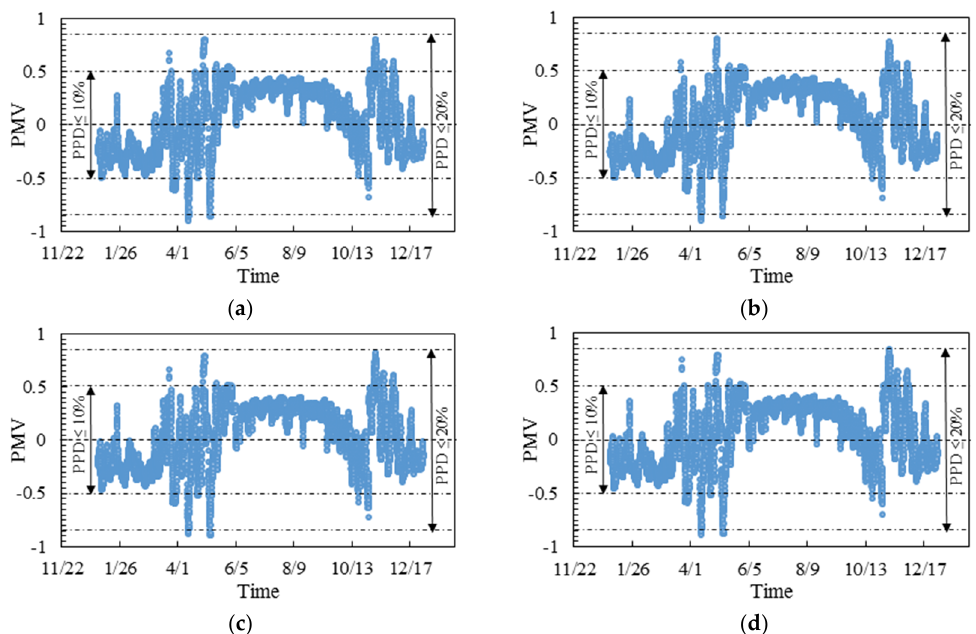
Figure 9. Bedroom thermal comfort with the HVAC system of ( a ) Bedroom 1; ( b ) Bedroom 2; ( c )